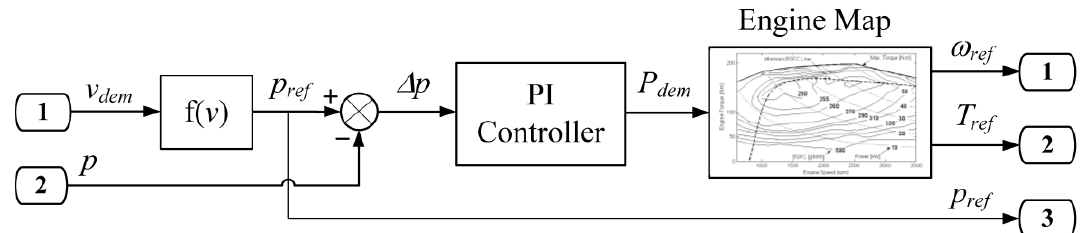
Figure 8. Schematic of the Supervisory